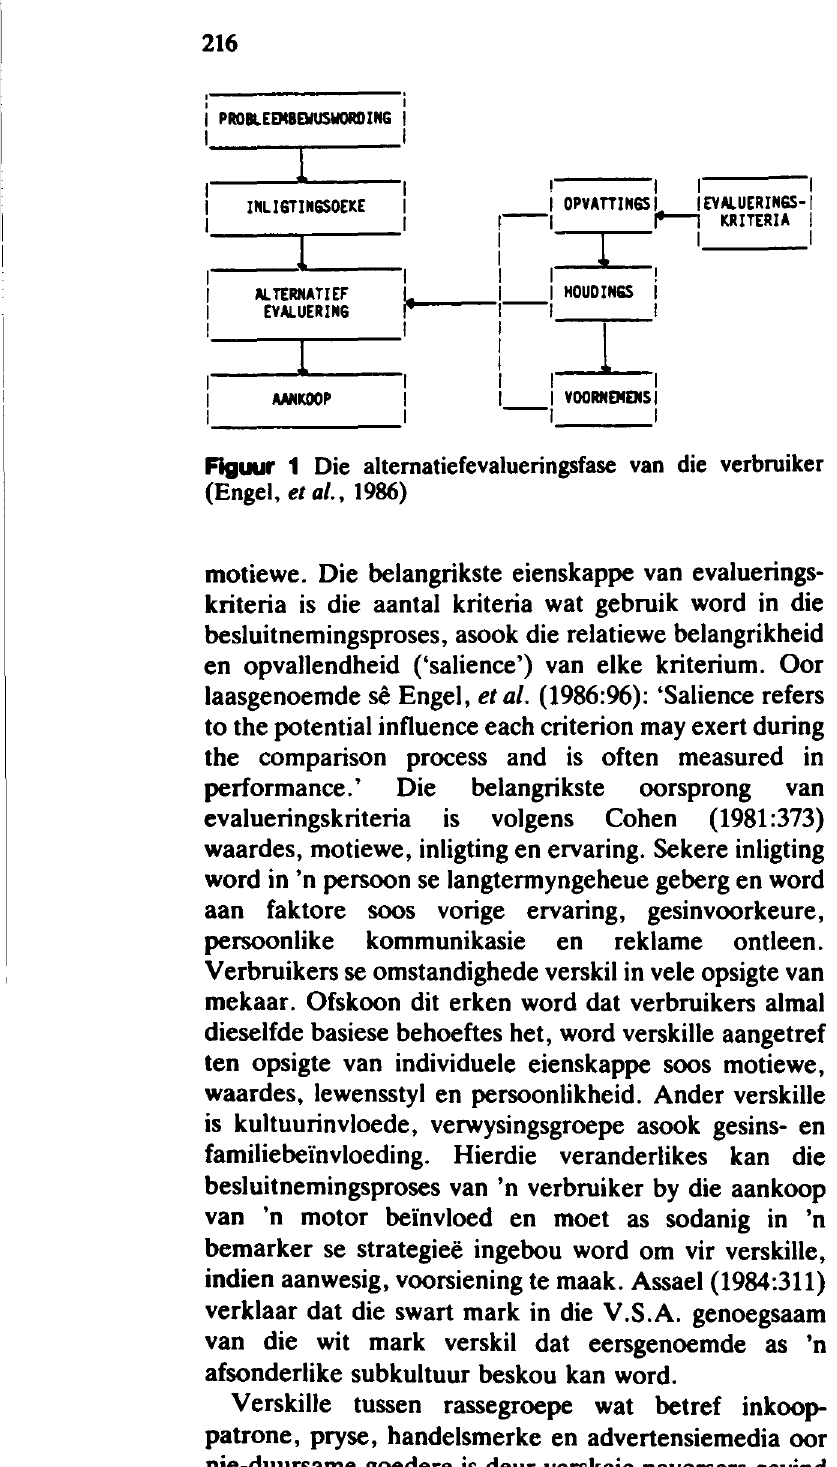
Figuur 1 Die altematiefevalueringsfase van die verbruiker (Engel, et al.,